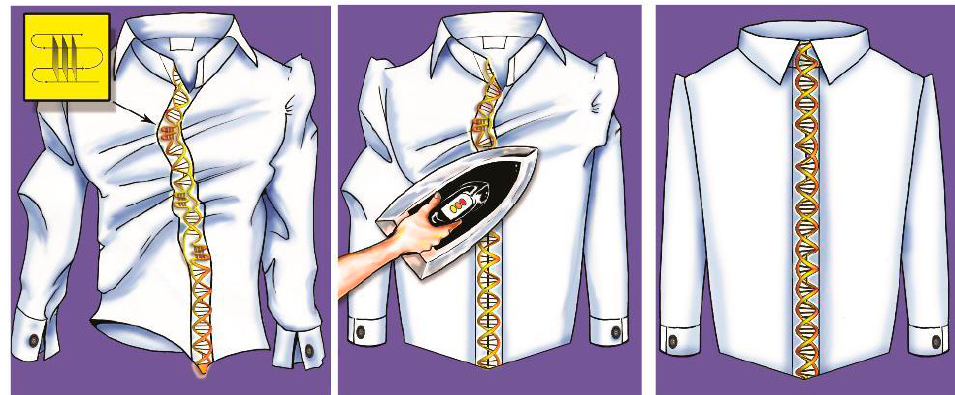
Figure 1. FANCJ irons out G4 DNA Wrinkles. G ‐ quadruplex (G4) DNA structures (inset) need to be resolved by G4 ‐ interacting proteins (e.g., FANCJ helicase) to provide a suitable template for replication and other DNA metabolic processes. Once FANCJ or other G4 ‐ interacting helicases remove the G4 DNA wrinkles, the protein machinery can smoothly copy, repair, or transcribe to maintain genomic stability and cellular homeostasis.